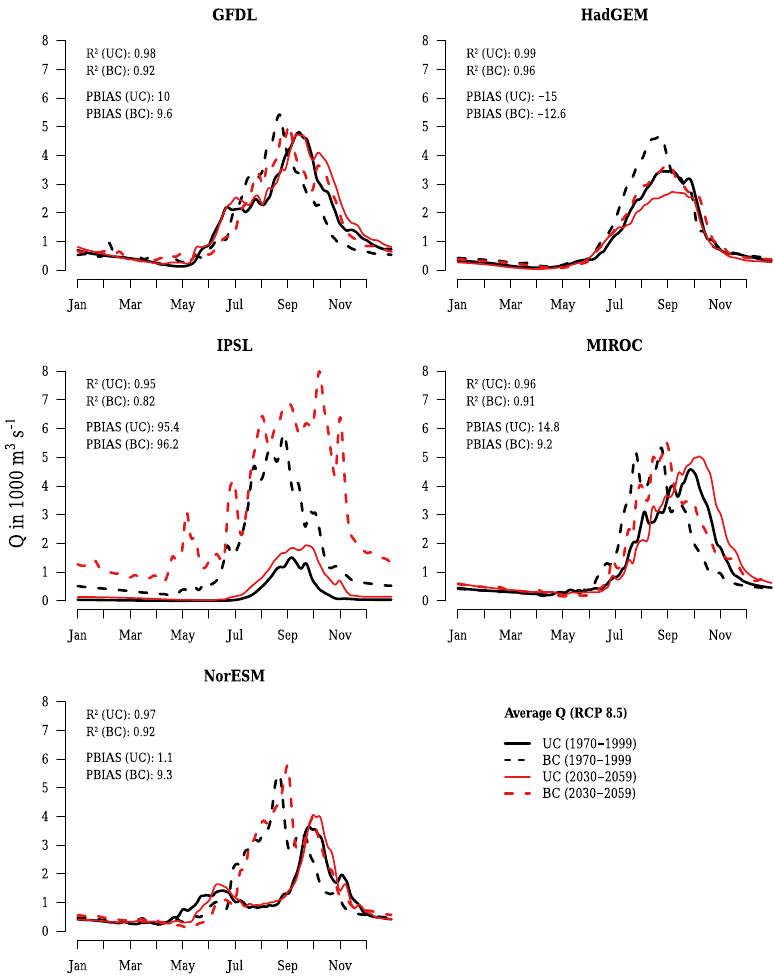
Figure 10. Changes of average daily discharges at gauge El Diem based on uncorrected (UC) and bias-corrected (BC) Earth system model (ESM) input in the period (2030–2059) under RCP8.5 relative to the models’ reference period (1970–1999). R 2 and PBIAS values are computed to show the differences between the projection period and the reference